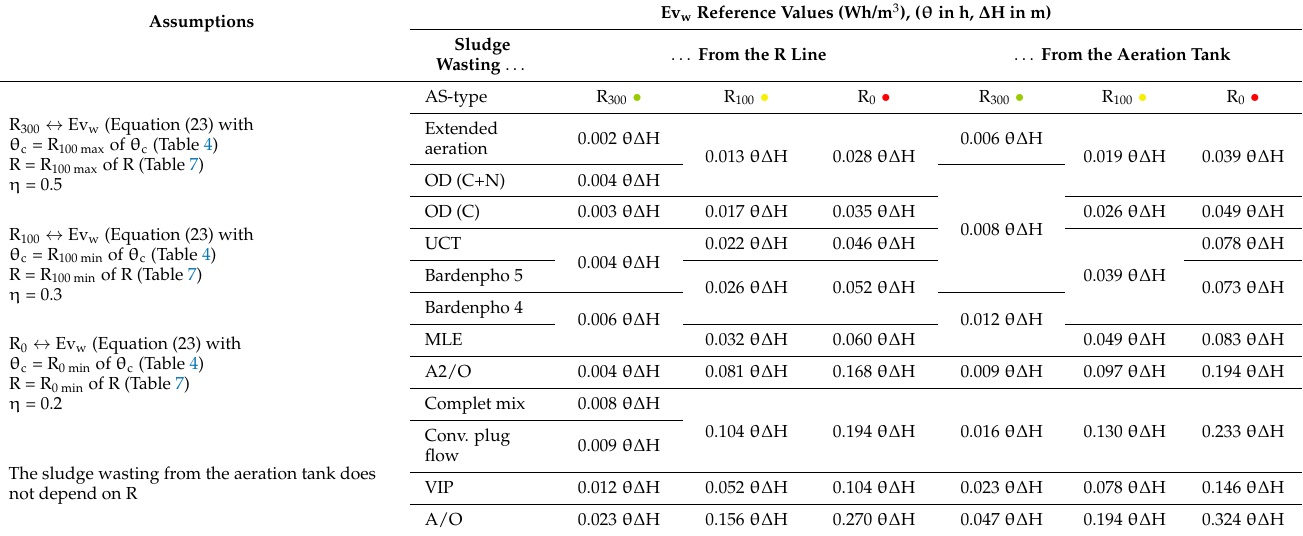
Table 11. The reference values of energy consumption for the sludge wasting in the AS